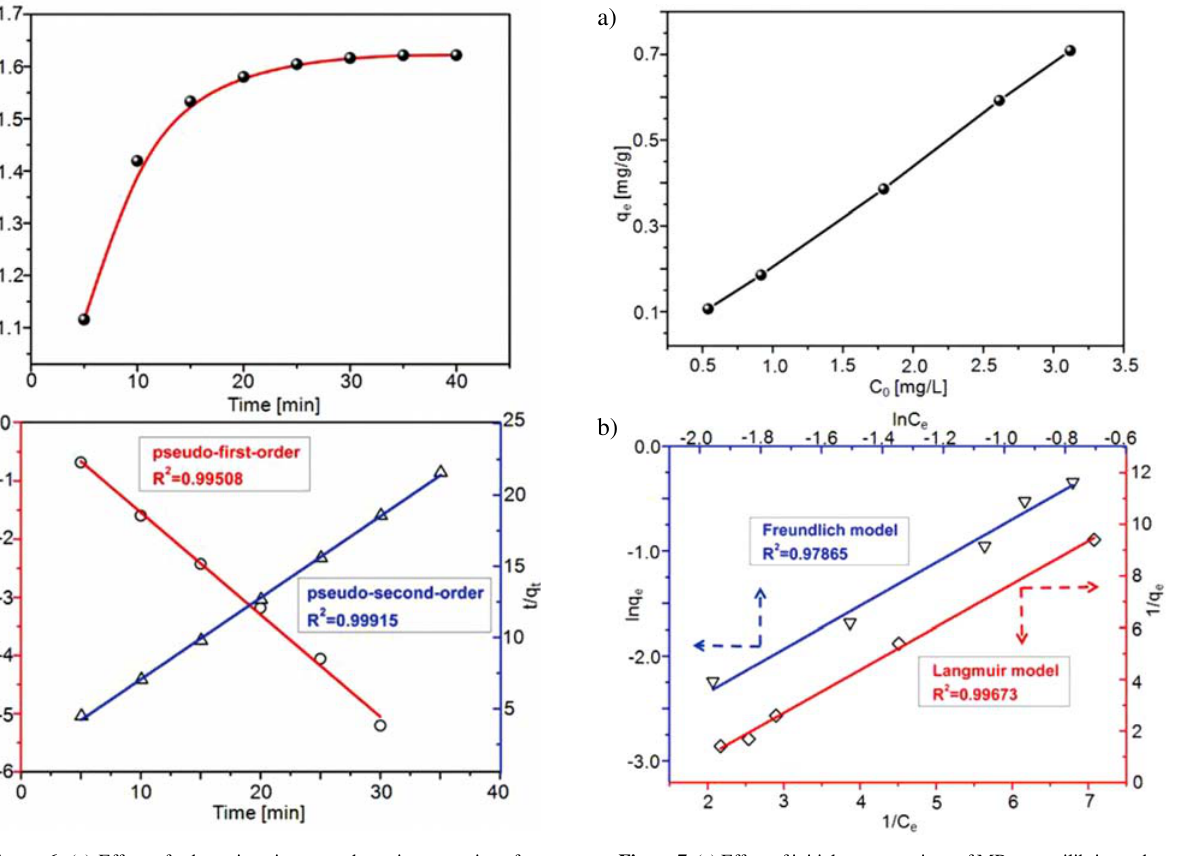
Figure 7. (a) Effect of initial concentrations of MB on equilibrium ad- /ESM in MB solutions. (b) Langmuir (red sorption capacity of MnO 2 line) and Freundlich (blue line) isotherms models for MB